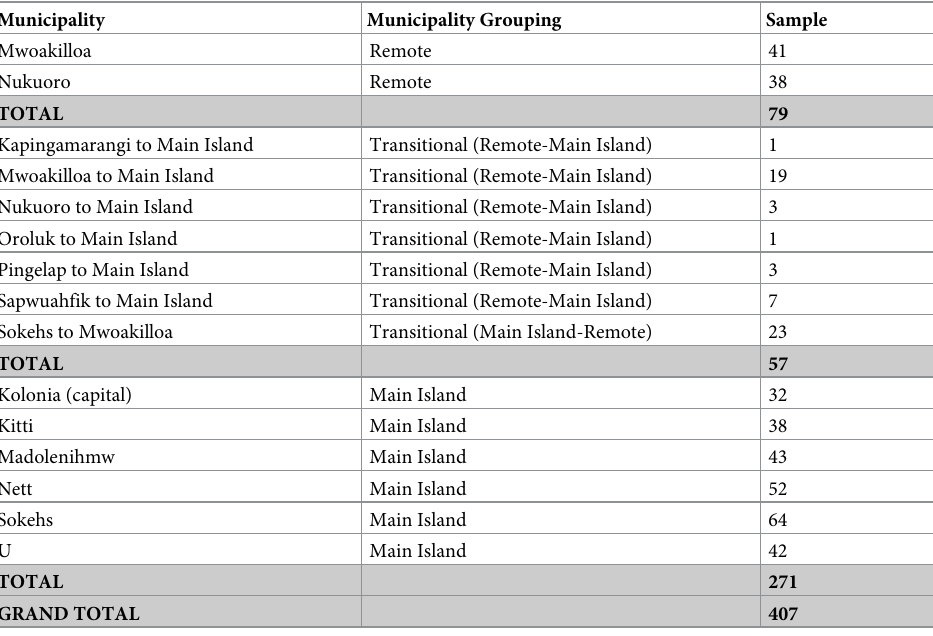
Table 1. Municipality classification for study